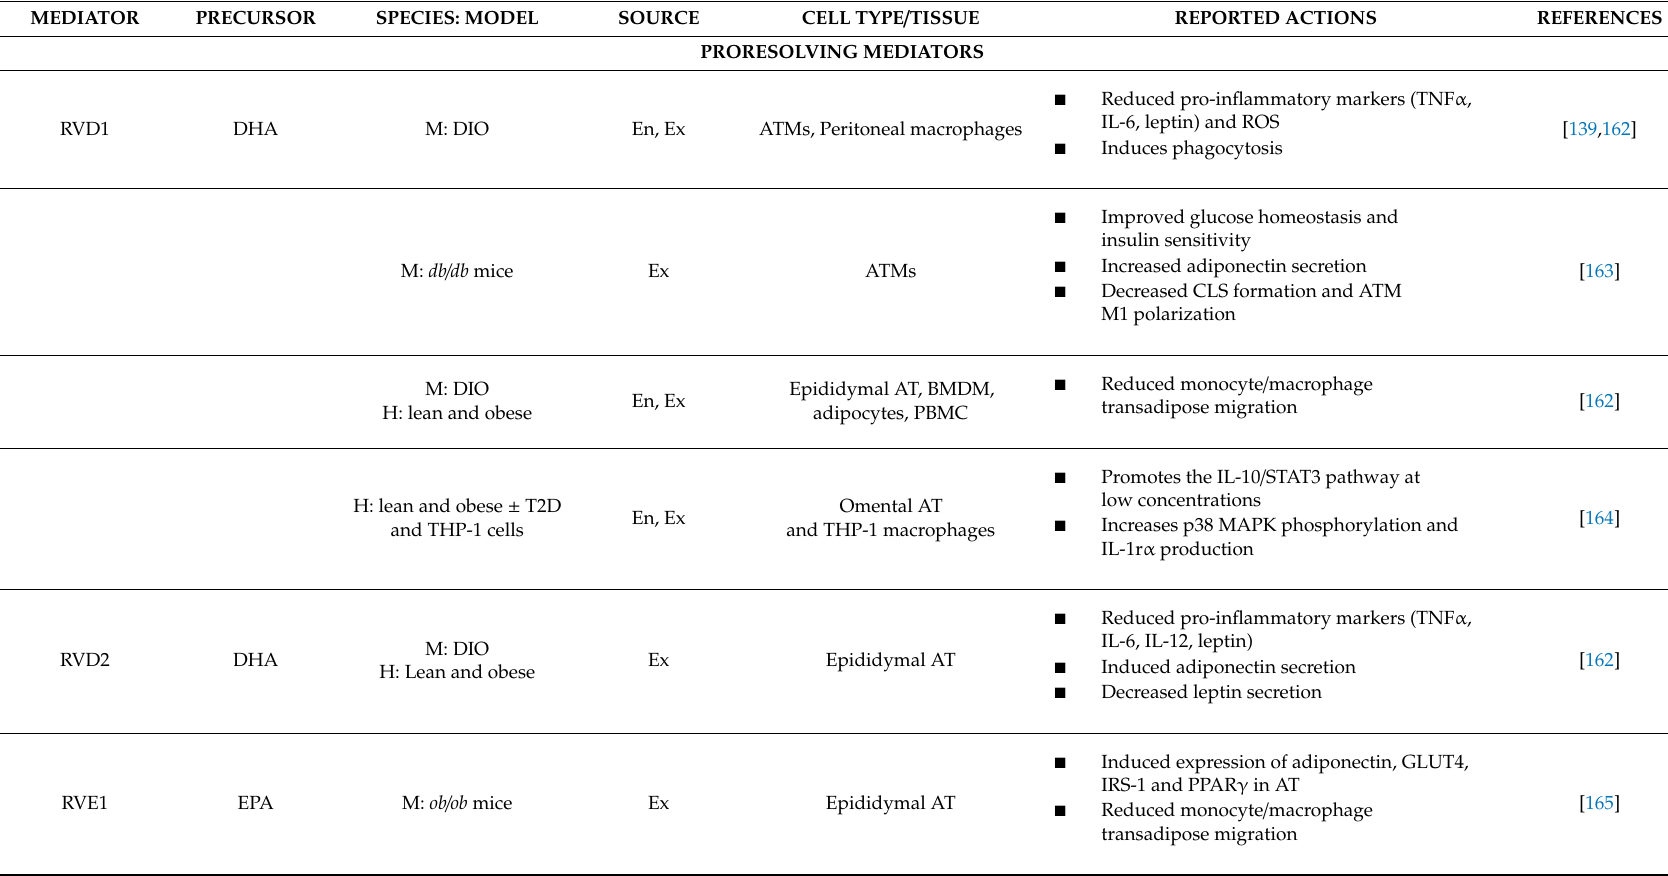
Table 1. Principal PUFA-derived lipid mediators in adipose tissue (AT) inflammation and ATM activation during obesity. H: human, M: mouse, R: rat, En: endogenous, Ex: